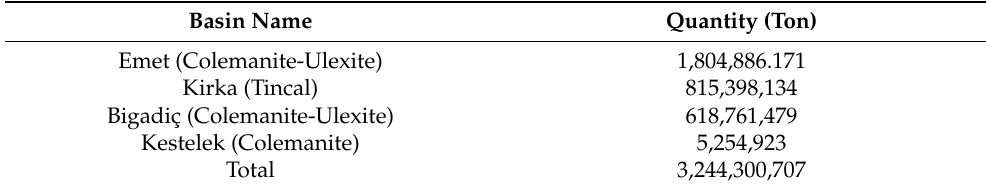
Table 3. Eti mines reserve amount-2020 [32,33].